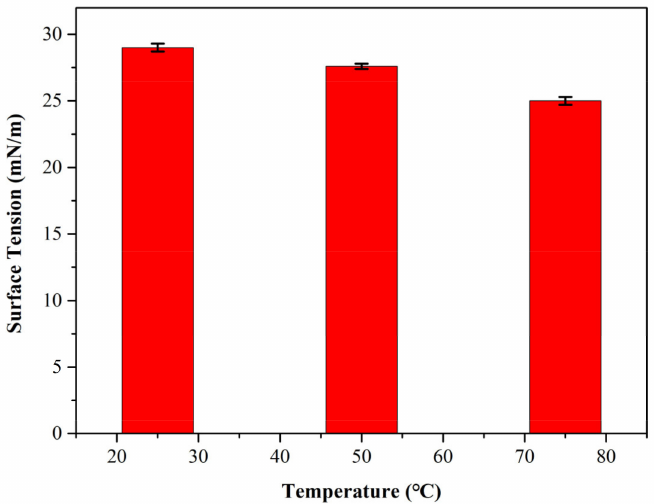
Figure 3. The surface tension of the resin at different temperatures.